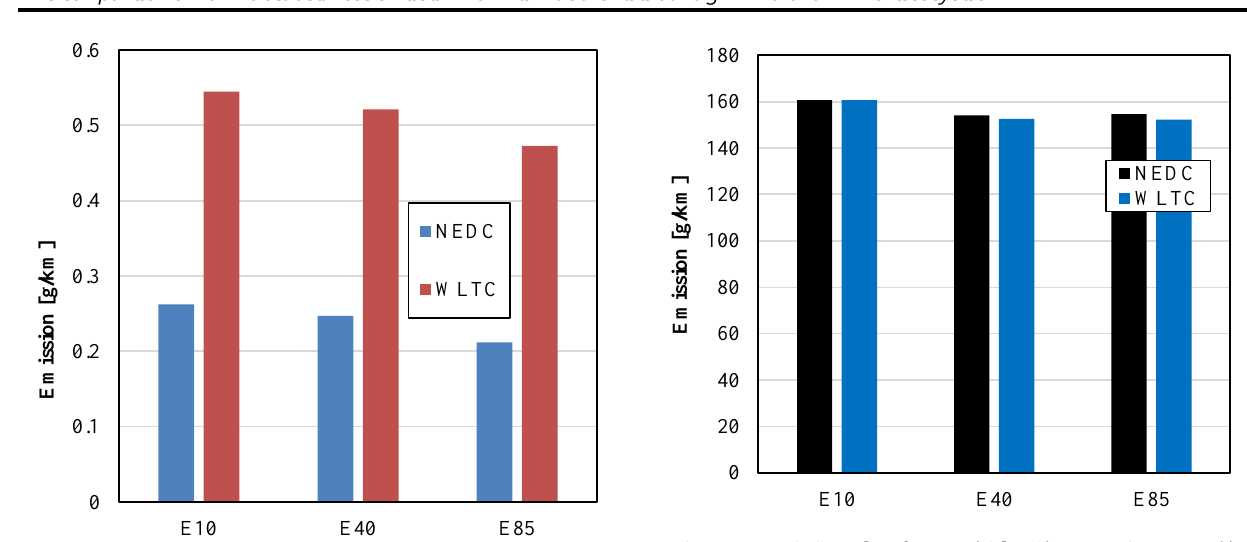
Fig. 7. CO 2 emission values from a vehicle with a SI engine powered by E10, E40 and E85 fuel in the NEDC and WLTC test cycle